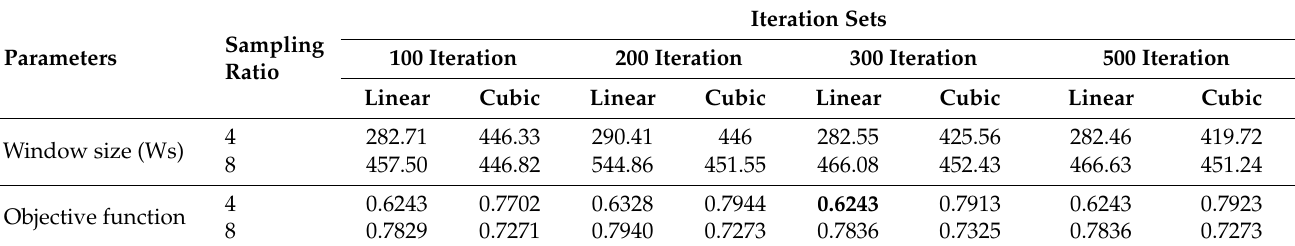
Table 2. The performance of CCWD-PSO technique in terms of Euclidean distance. The comparison involves several cross-correlation-related parameters. The sampling parameter indicates the interpolation ratio of the cross-correlation output signal. Two interpolation methods were used, i.e., linear and